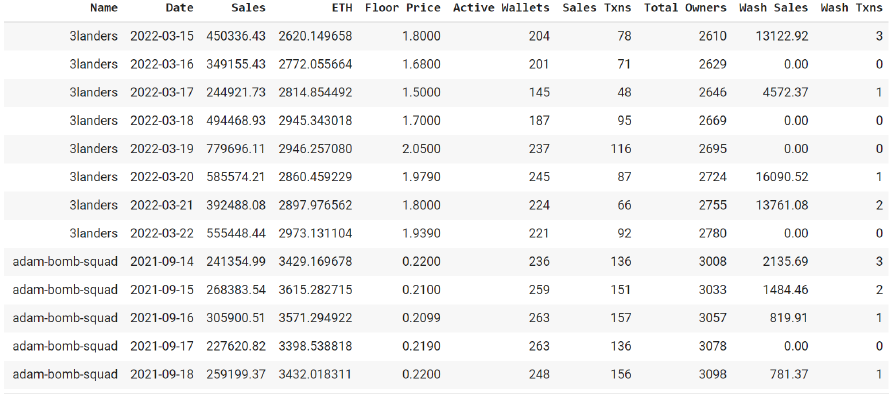
Figure 1. A snapshot of the reference dataset after the ETL